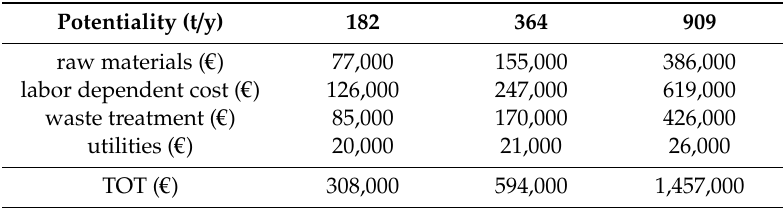
Table 6. Operating cost breakdown for the di ff erent